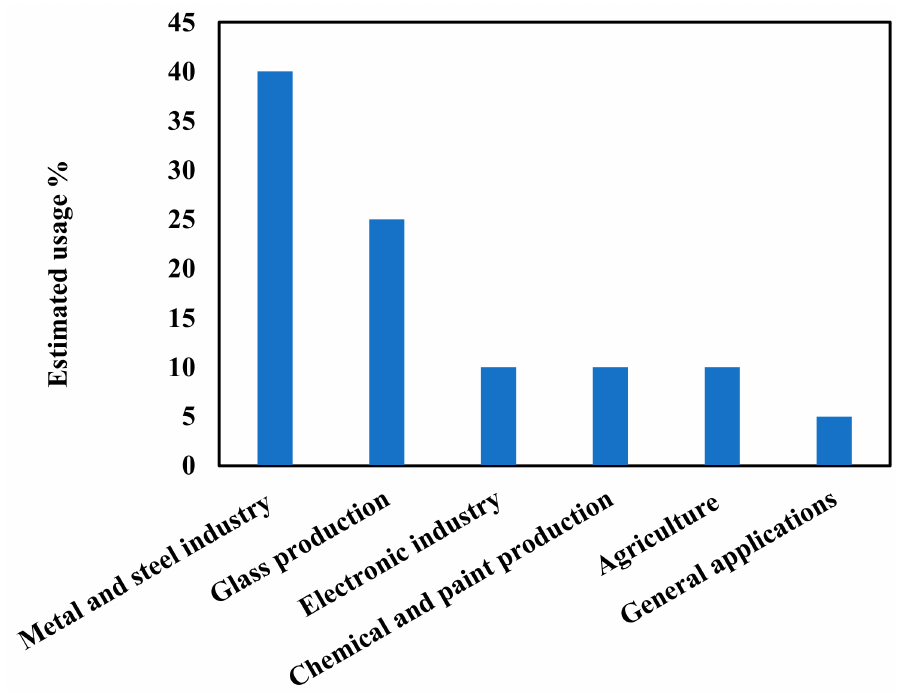
Figure 4. Selenium usages in some industries adapted from